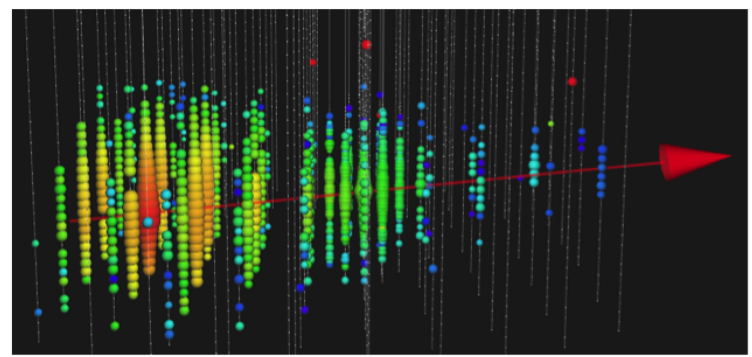
Figure 1. IceCube-160427A, the first real time neutrino alert sent by IceCube, on April 27, 2016. It is a starting ν µ event. Here DOMs are indicated as dots. Colored spheres are DOMs reporting signals, with red being early and blue, being late. The red arrow indicates the best reconstructed track